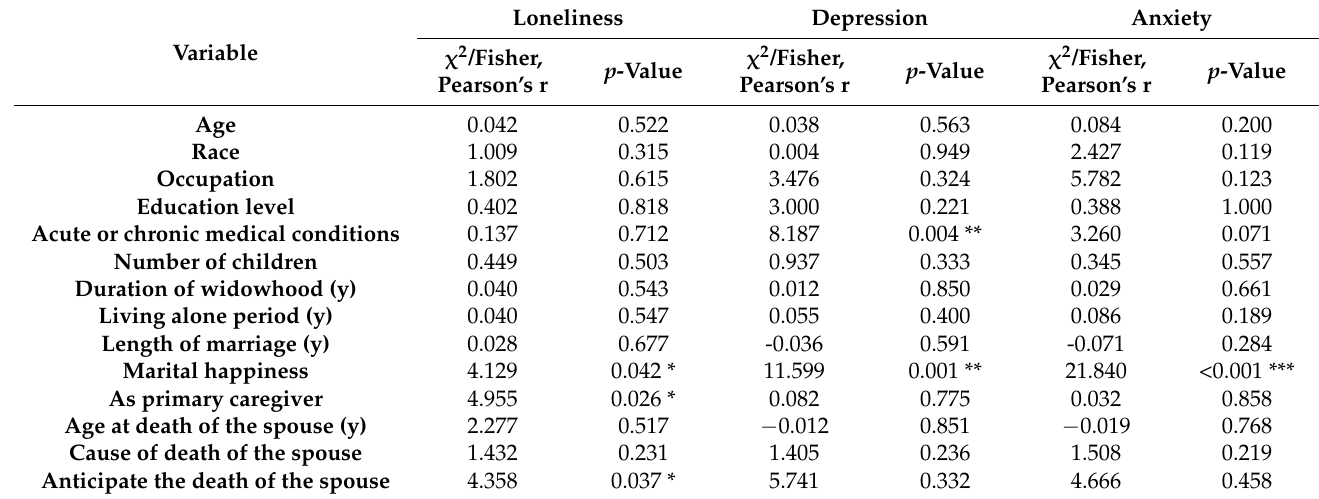
Table 3. Univariate analysis of loneliness, depression, and anxiety (N =